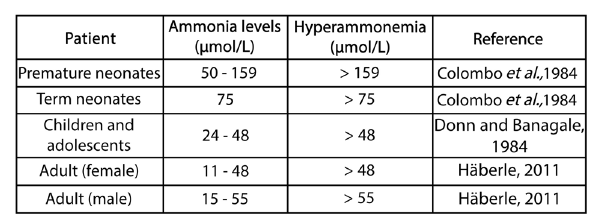
FIGURE 3 | Ammonia concentration serum in different